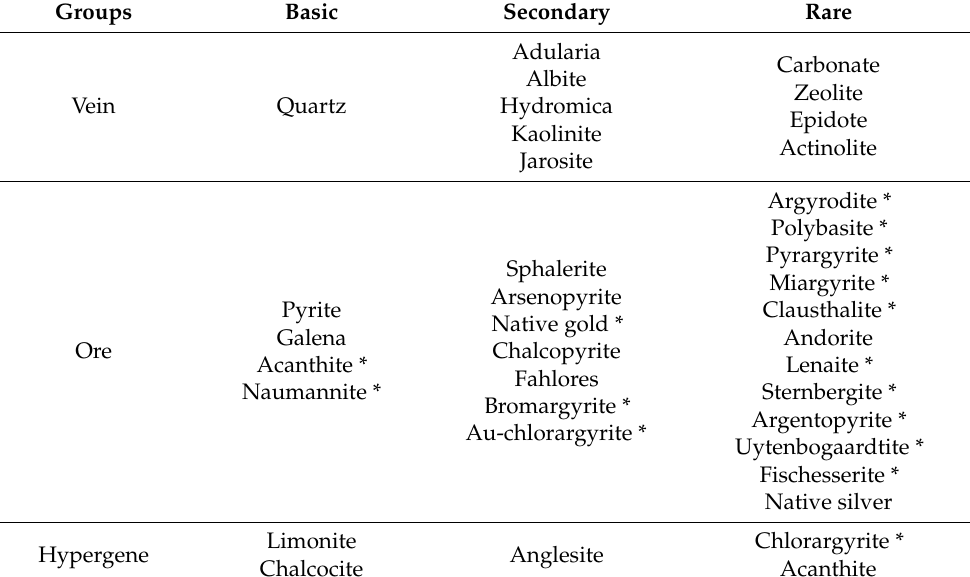
Table 1. Mineral composition of Corrida